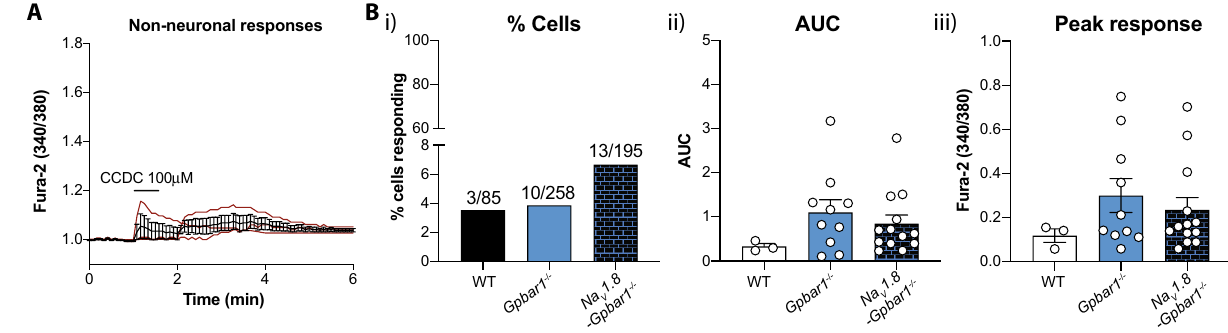
Figure 9. Intracellular calcium responses to CCDC in non-neuronal cells from wildtype, Gpbar1 −/− and Na V 1.8‑Gpbar1 −/− mice. ( A ) Intracellular calcium changes were measured in non-neuronal cells from wildtype (WT: black), Gpbar1 −/− (light blue) and Na V 1.8 - Gpbar1 −/− (dark blue) mice in response to CCDC (100 µM). Mean ± SEM of intracellular Ca 2+ responses to CCDC (100 μM) in non-neuronal cells from wildtype mice. Red lines represent the three individual responding cells (3/85). ( B ) ( i ) The percentage (%) of non-neuronal cells responding to CCDC (100 µM). 3.5% (3 out of 85), 3.88% (10 out of 258) and 6.67% (13 out of 195) of non- neuronal cells from wildtype, Gpbar1 −/− , and Na V 1.8- Gpbar1 −/− respectively responded to CCDC (100 µM). ( ii ) No significant differences were observed in either the average intracellular calcium response over time or ( ii ) the peak fluorescent response to 100 µM CCDC between non-neuronal cells from wildtype, Gpbar1 −/− (light blue) and Na V 1.8- Gpbar1 −/− (dark blue) mice. Data are represented as percentage of cells ( Bi ) or Mean ± SEM ( Bii , Biii ), with individual data points representing values from individual cells. Significance was determined by Kruskal–Wallis non-parametric analysis of variance with Dunn’s multiple comparisons tests ( Bii , Biii